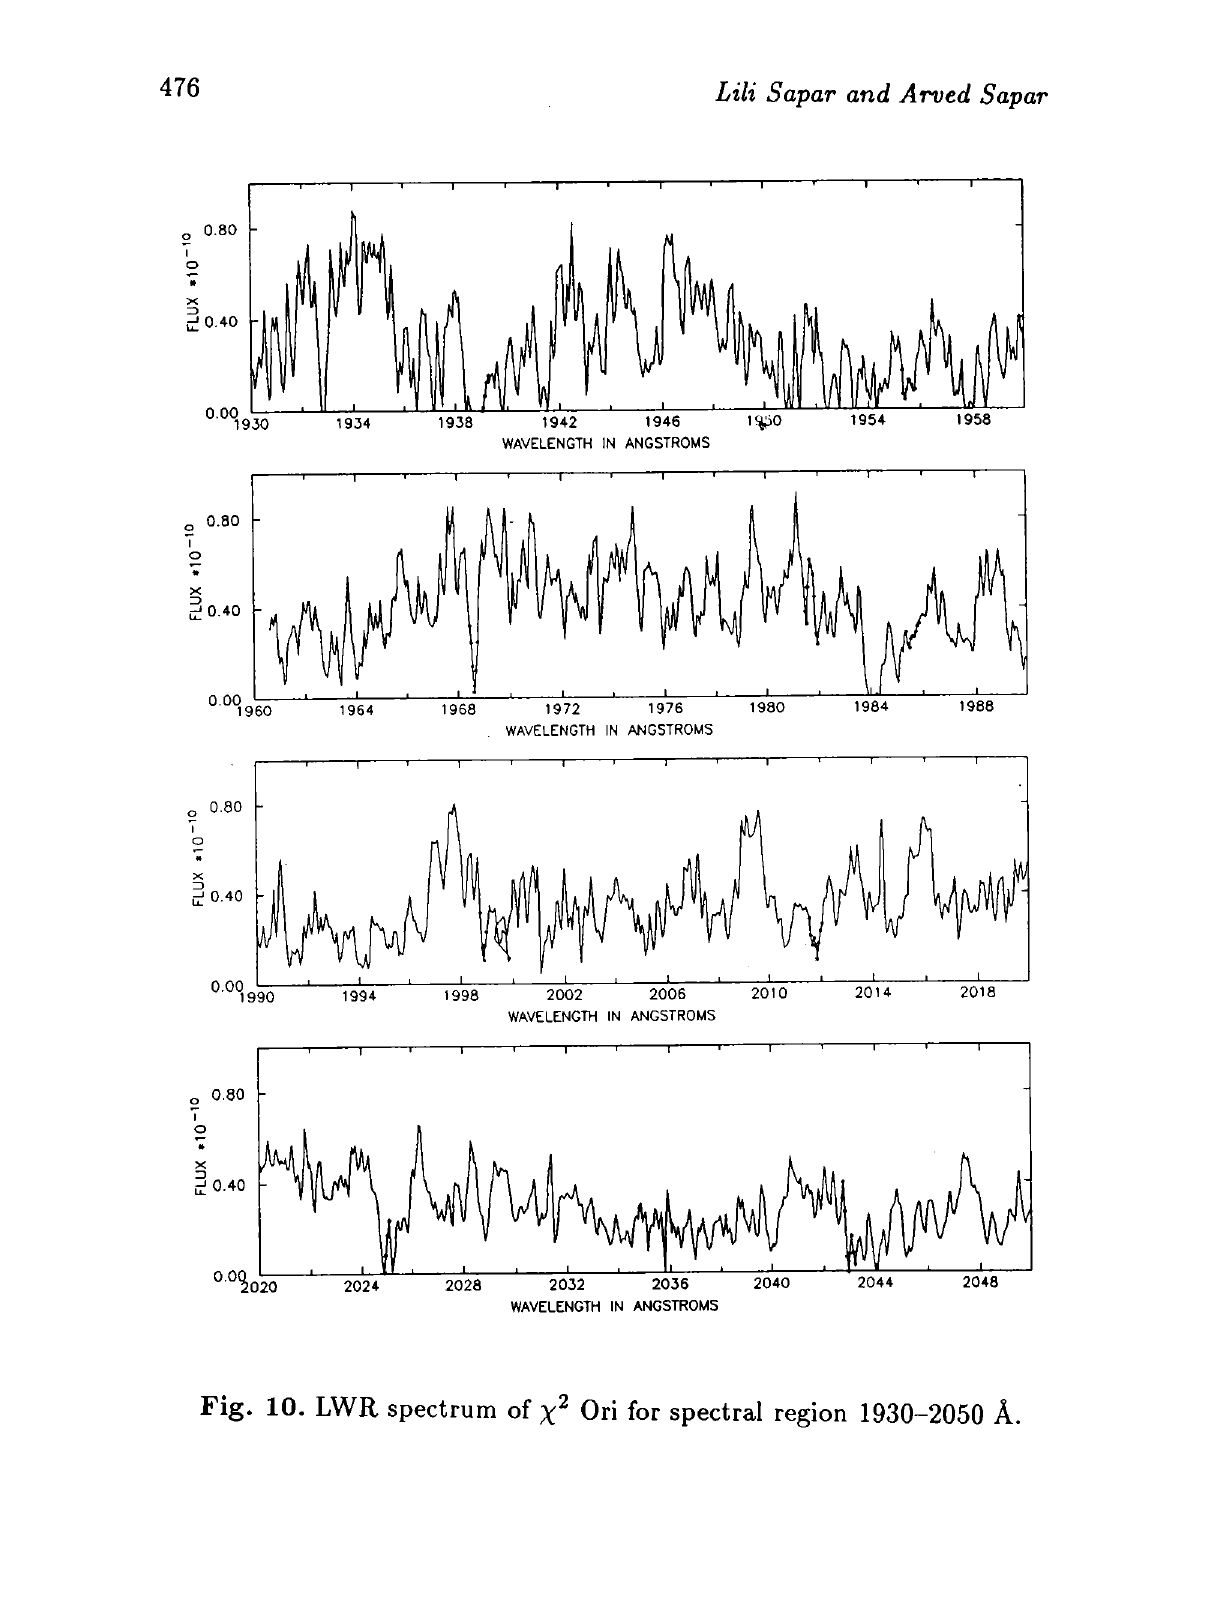
Fig. 10. LWR spectrum of x 2 Ori for spectral region 1930-2050